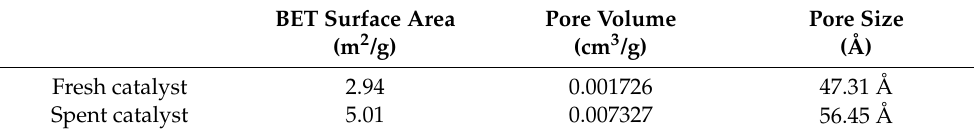
Table 3. Specific surface area of the 3 wt.% Ni/Ce-Zr-Mg/Al 2 O 3 catalyst.